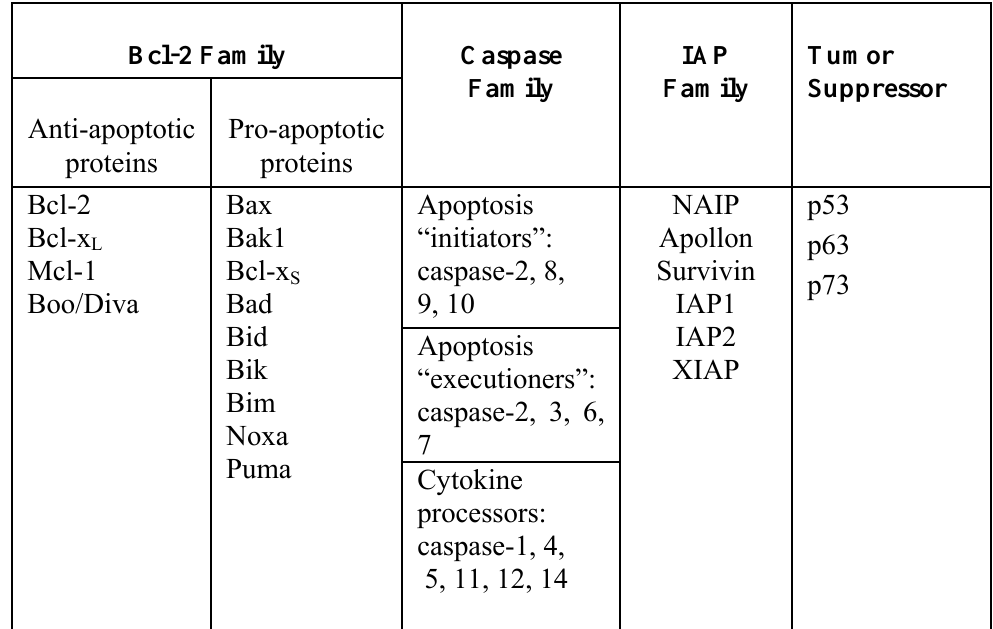
Table 2. Some Molecular Regulators of Apoptosis Relevant to Neurodegeneration and Potential Drug Targeting for